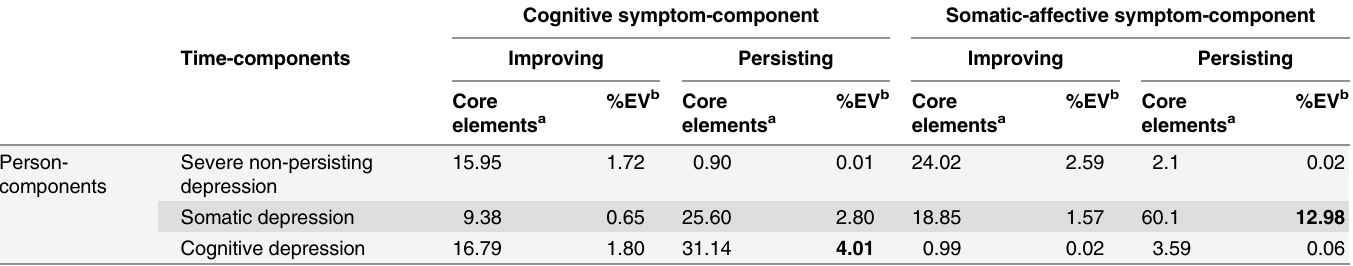
Table 4. The core array of the 3MPCA model including the percentages of explained variance. %EV = percentages explained variances of rotated components for each combination of components.